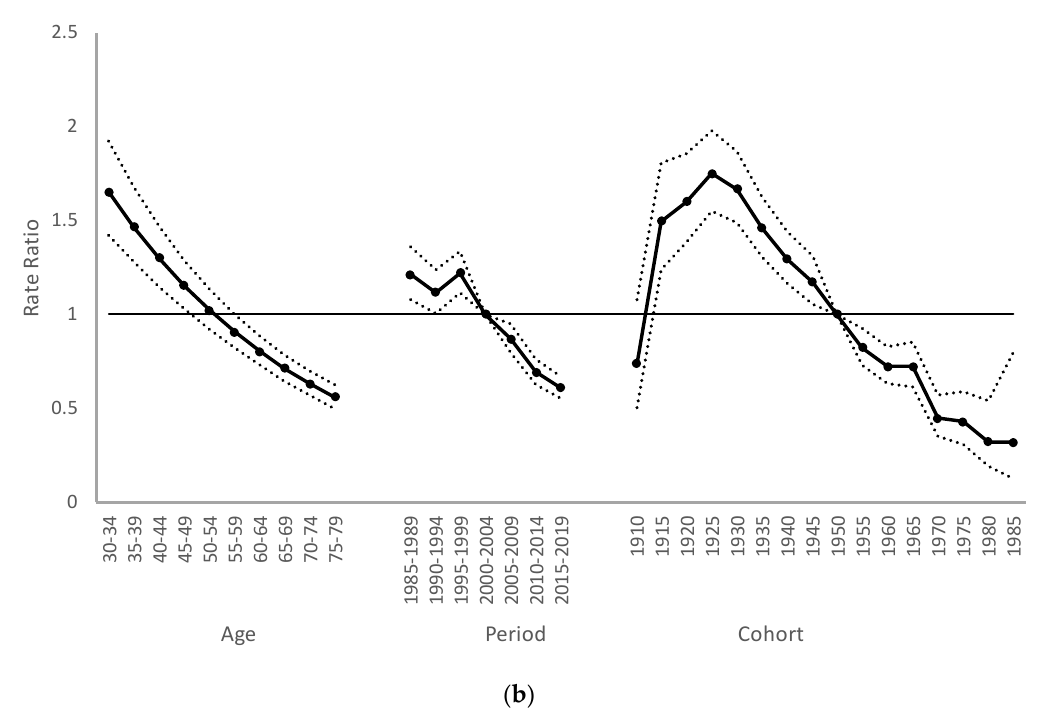
Figure 4. Age-period-cohort effect of squamous cell lung carcinoma: ( a ) men and ( b ) women.